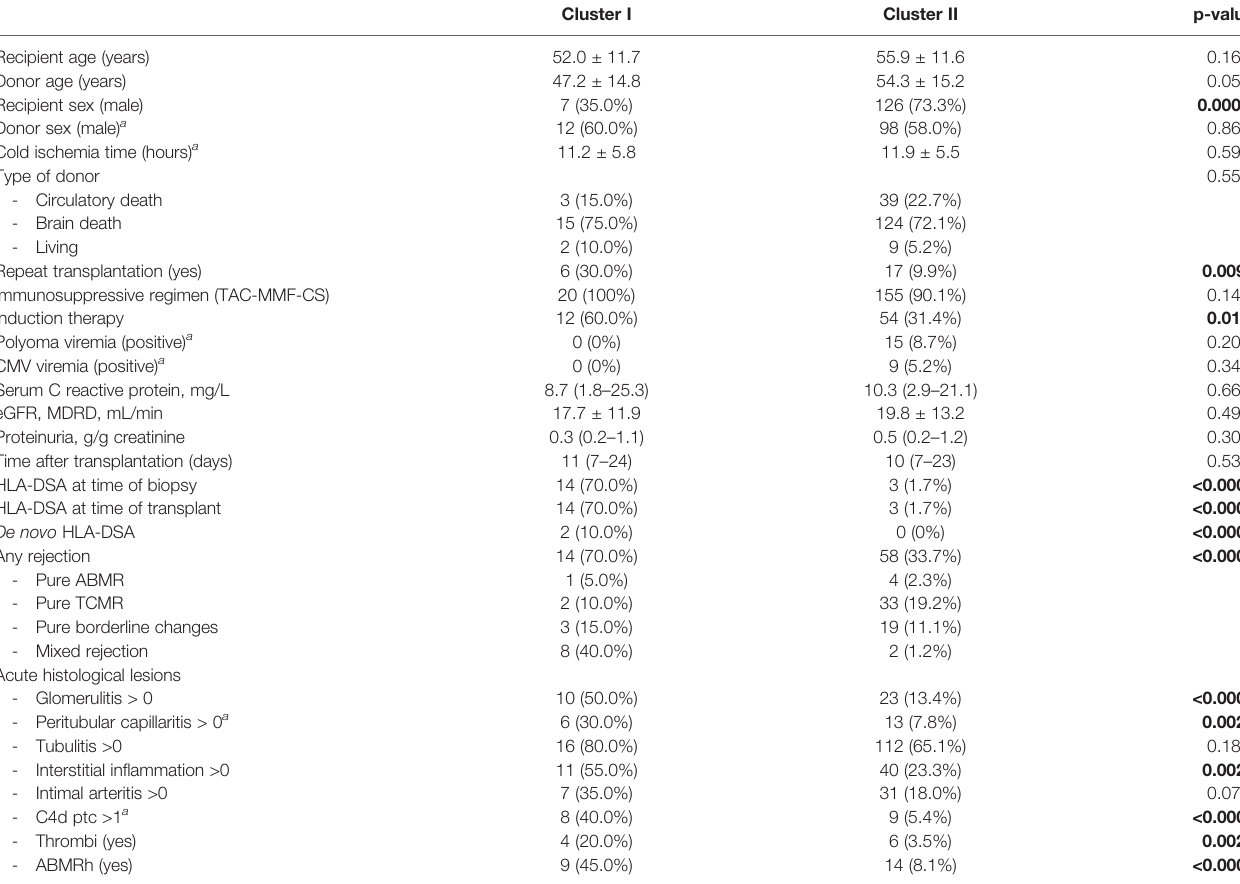
TABLE 2 | Comparison of clinical characteristics between cluster I (N = 20) and cluster II (N =